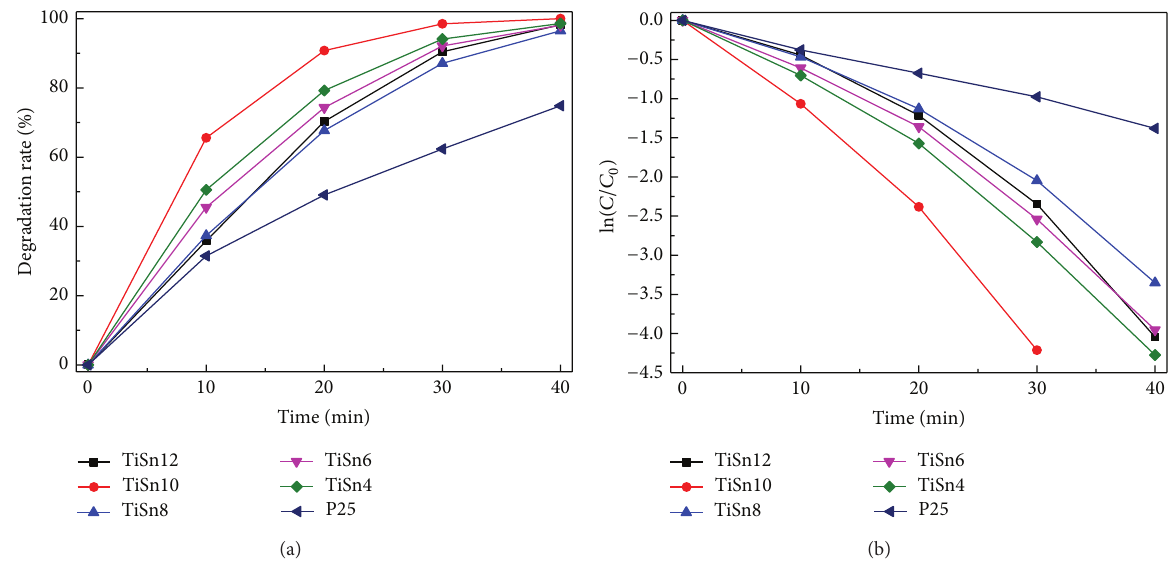
Figure 5: The photocatalytic degradation rate (a) and the pseudo-first-order kinetics (b) of the prepared samples and Degussa P25. Table 1: The textural properties of the investigated catalysts. Samples